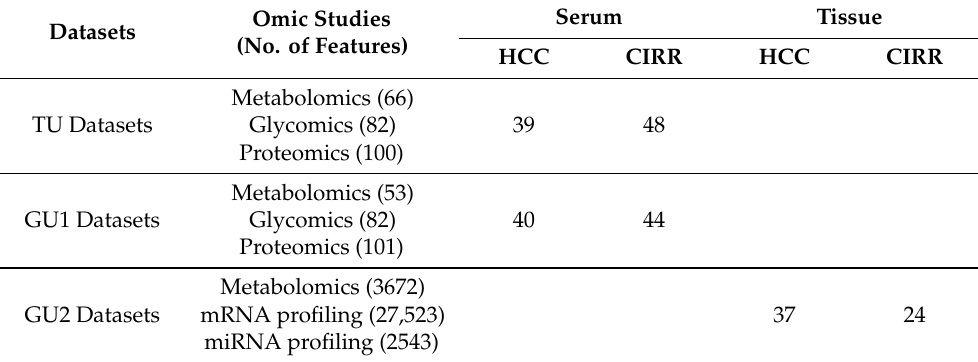
Table 1. Multi-omic datasets acquired from three cohorts. The number of features in each omic dataset and the number of serum and tissue samples analyzed by multi-omic approaches are shown.